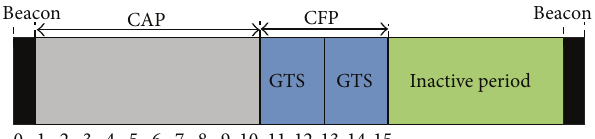
Figure 6: 802.15.4 MAC Superframe structure (redrawn from [46]).